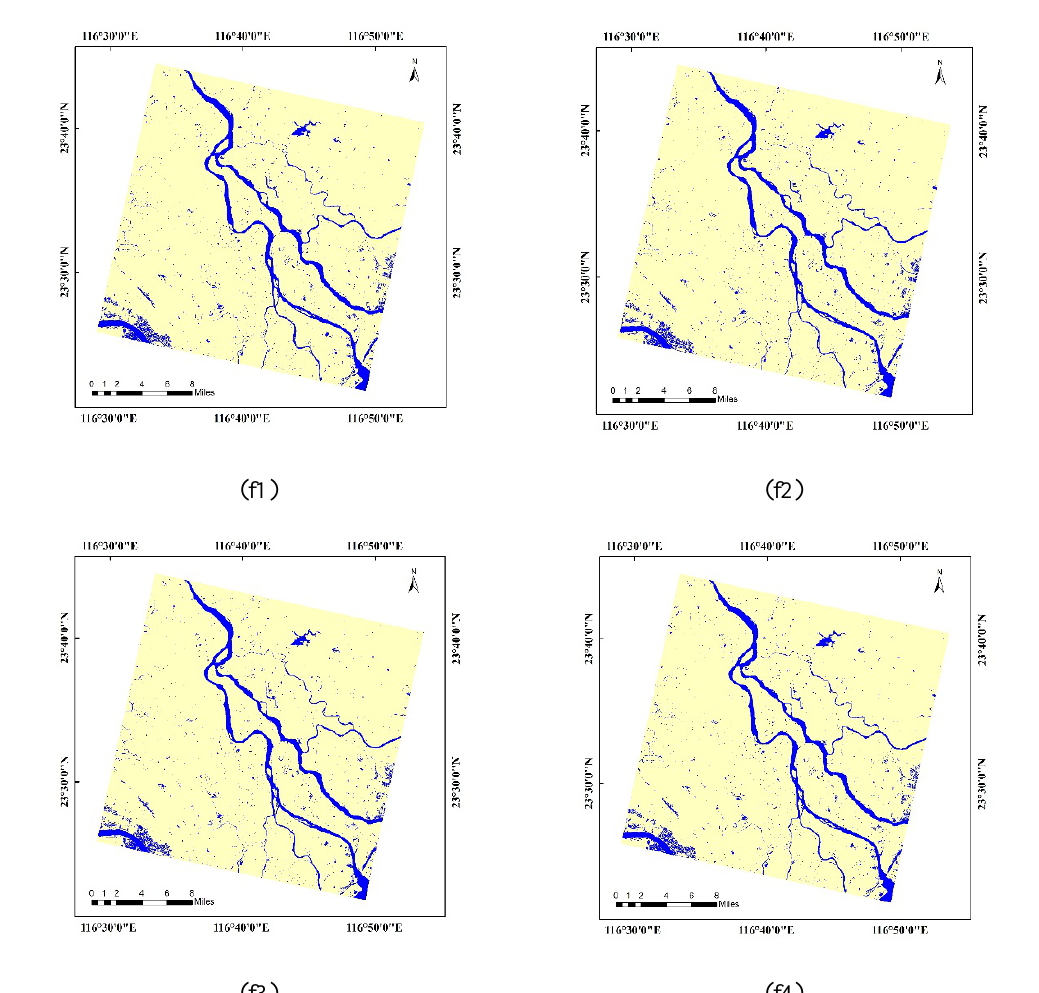
Figure 8. f1-f4 is the experimental results of 0.1%, 0.2%, 1% and 2% AdaBoost classification algorithm,